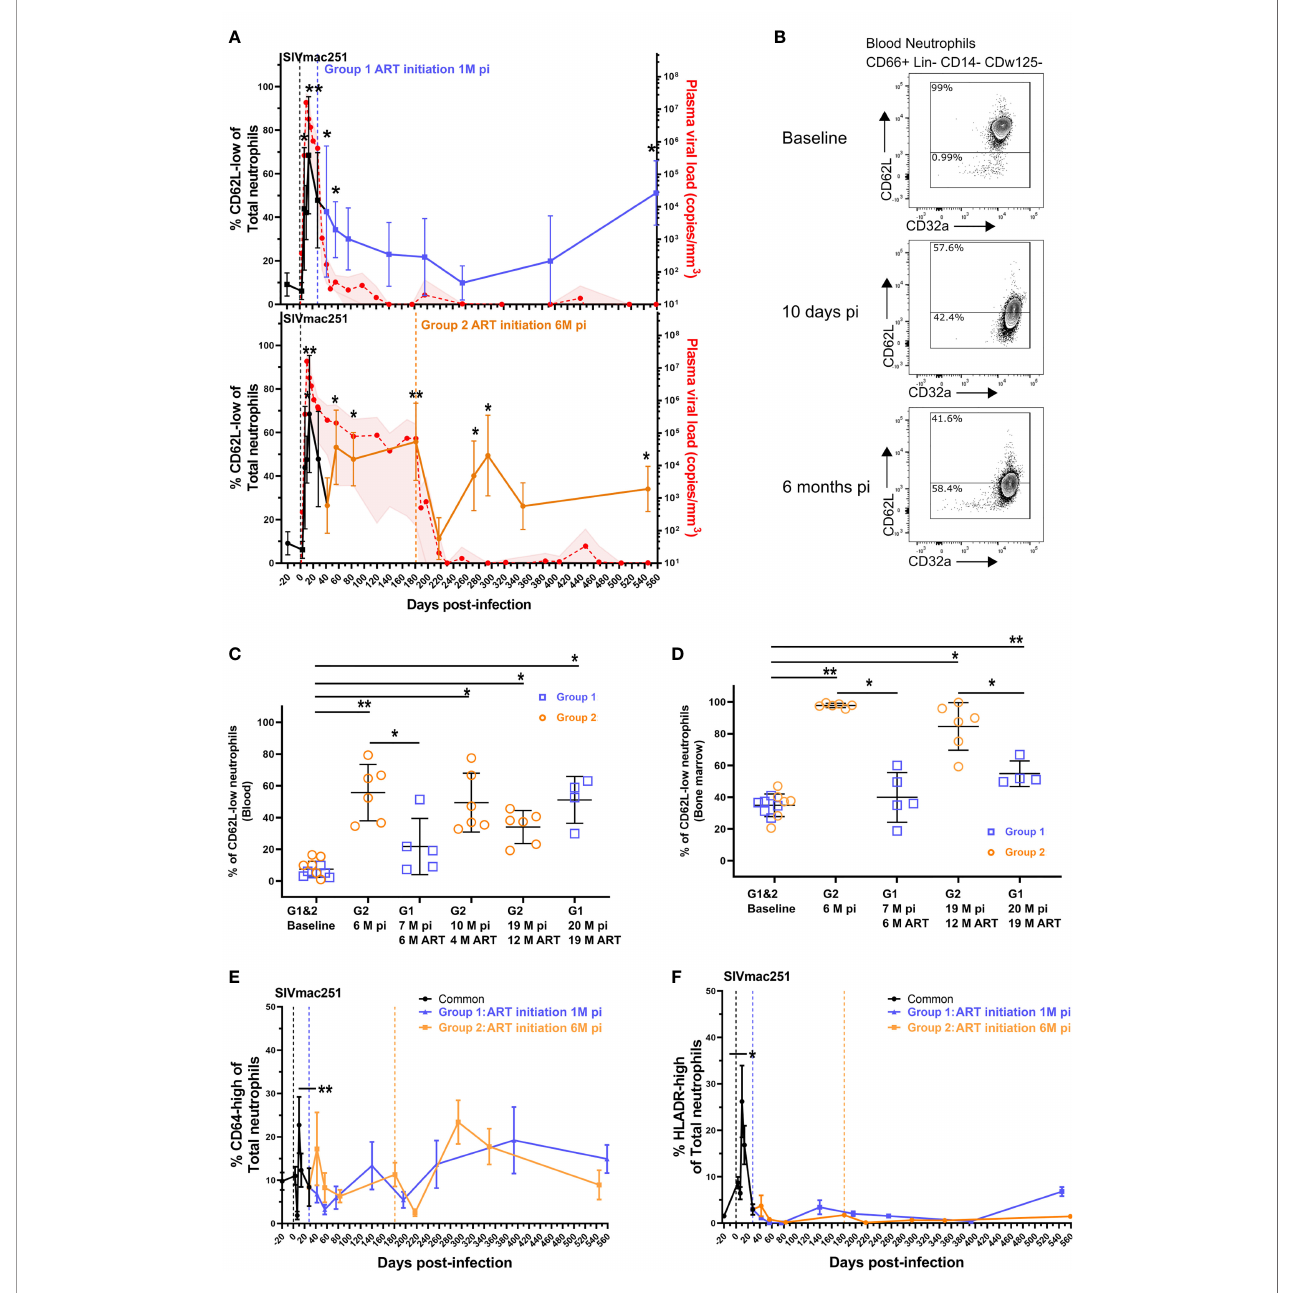
FIGURE 1 | Neutrophil priming during the course of SIV infection and cART. (A) Follow-up of blood CD62L-low neutrophil frequency and plasma viral loads in both groups. Values shown in the graphs indicate the mean with the SD of the CD62L-low frequency and the mean, with the range, of plasma viral load. The black curve represents the data points of the 12 animals from both groups before cART initiation. *p < 0.05, **p < 0.01 by the paired Friedman test with Dunn ’ s multiple comparison of the CD62L-low frequency compared to baseline values for the 6 animals studied in each group. The blue (upper graph) and orange (lower graph) curves represent the data in the early cART and late cART treated animals. The red curve shows the plasma viral load for the 12 animals till 28 dpi and for the 6 animals included in each group for the latter time point. (B) Representative fl ow cytometry data plots displaying CD62L and CD32a expression in CD66+ Lin- CD14- CDw125- neutrophils from one macaque before cART. (C, D) Frequency of CD62L-low PMNs in blood (C) and bone marrow (D) during different stages of infection and cART. The values in the graphs indicate the mean with the SD of each neutrophil population. *p < 0.05, **p < 0.01 by the paired Friedman test with Dunn ’ s multiple comparison and Mann Whitney tests for unpaired comparisons. (E, F) Frequency of CD64-high and HLADR+ PMNs in the blood for both groups. Before cART initiation for Group 1, both groups are represented together in the black line and then separated. The values in the graphs indicate the mean with the SD of the CD64-high or HLADR + PMN frequency. *p < 0.05, **p < 0.01 by the paired Friedman test with Dunn ’ s multiple